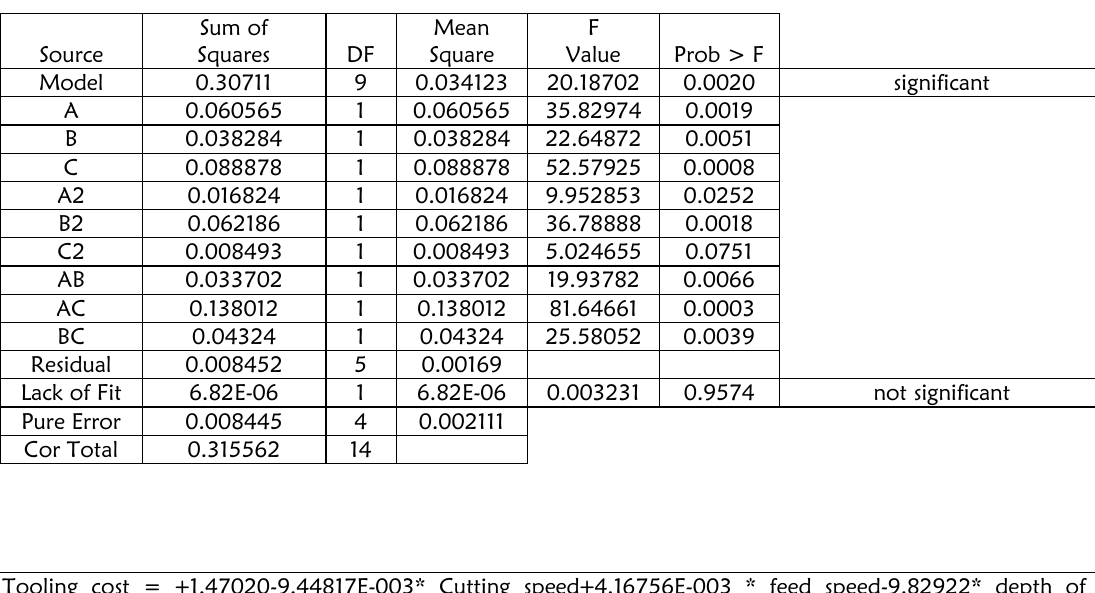
Table 3: ANOVA table for tooling cost.